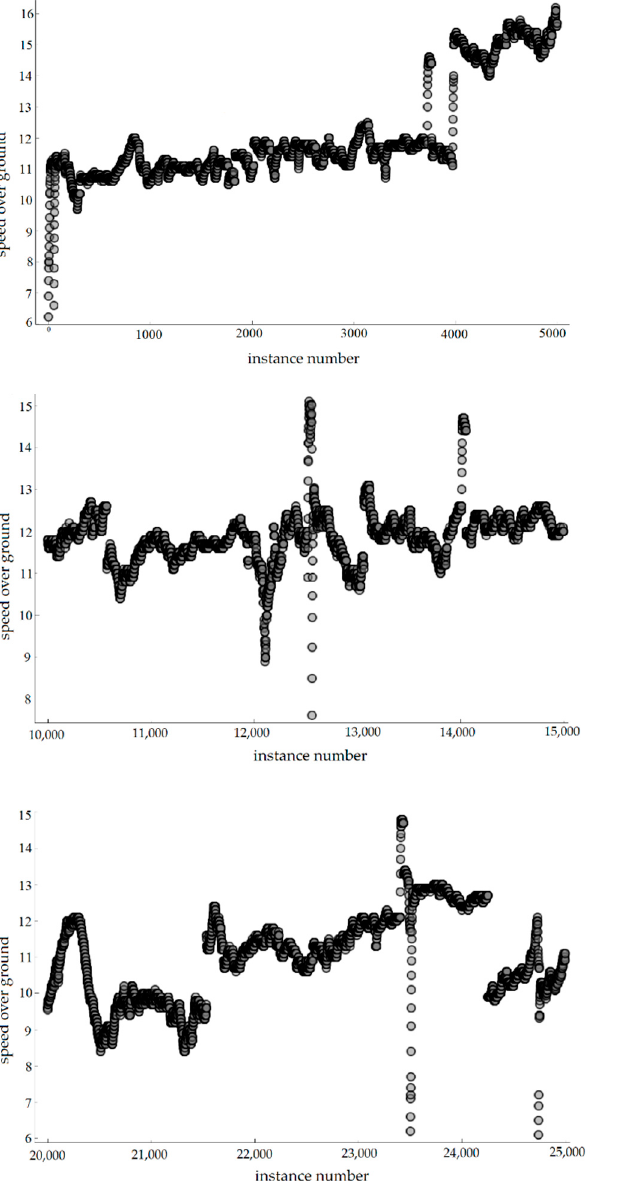
10 of 18 Figure 6. The ship’s cruising speed distribution.